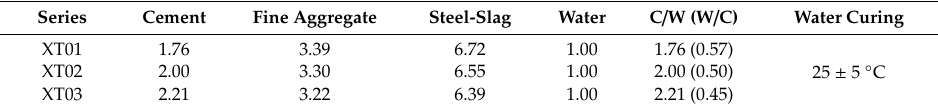
Table 1. Composition of steel-slag concretes.